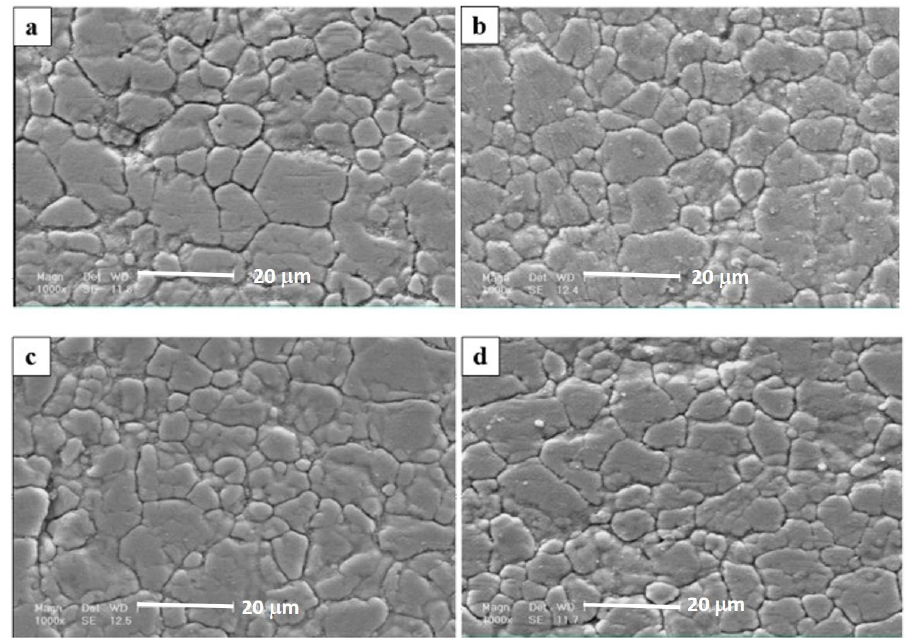
Figure 2. SEM images showing the surface morphology of ( a ) Nb-HT, ( b ) NbN-RT, ( c ) NbN-HT, ( d ) Nb / NbN-HT.